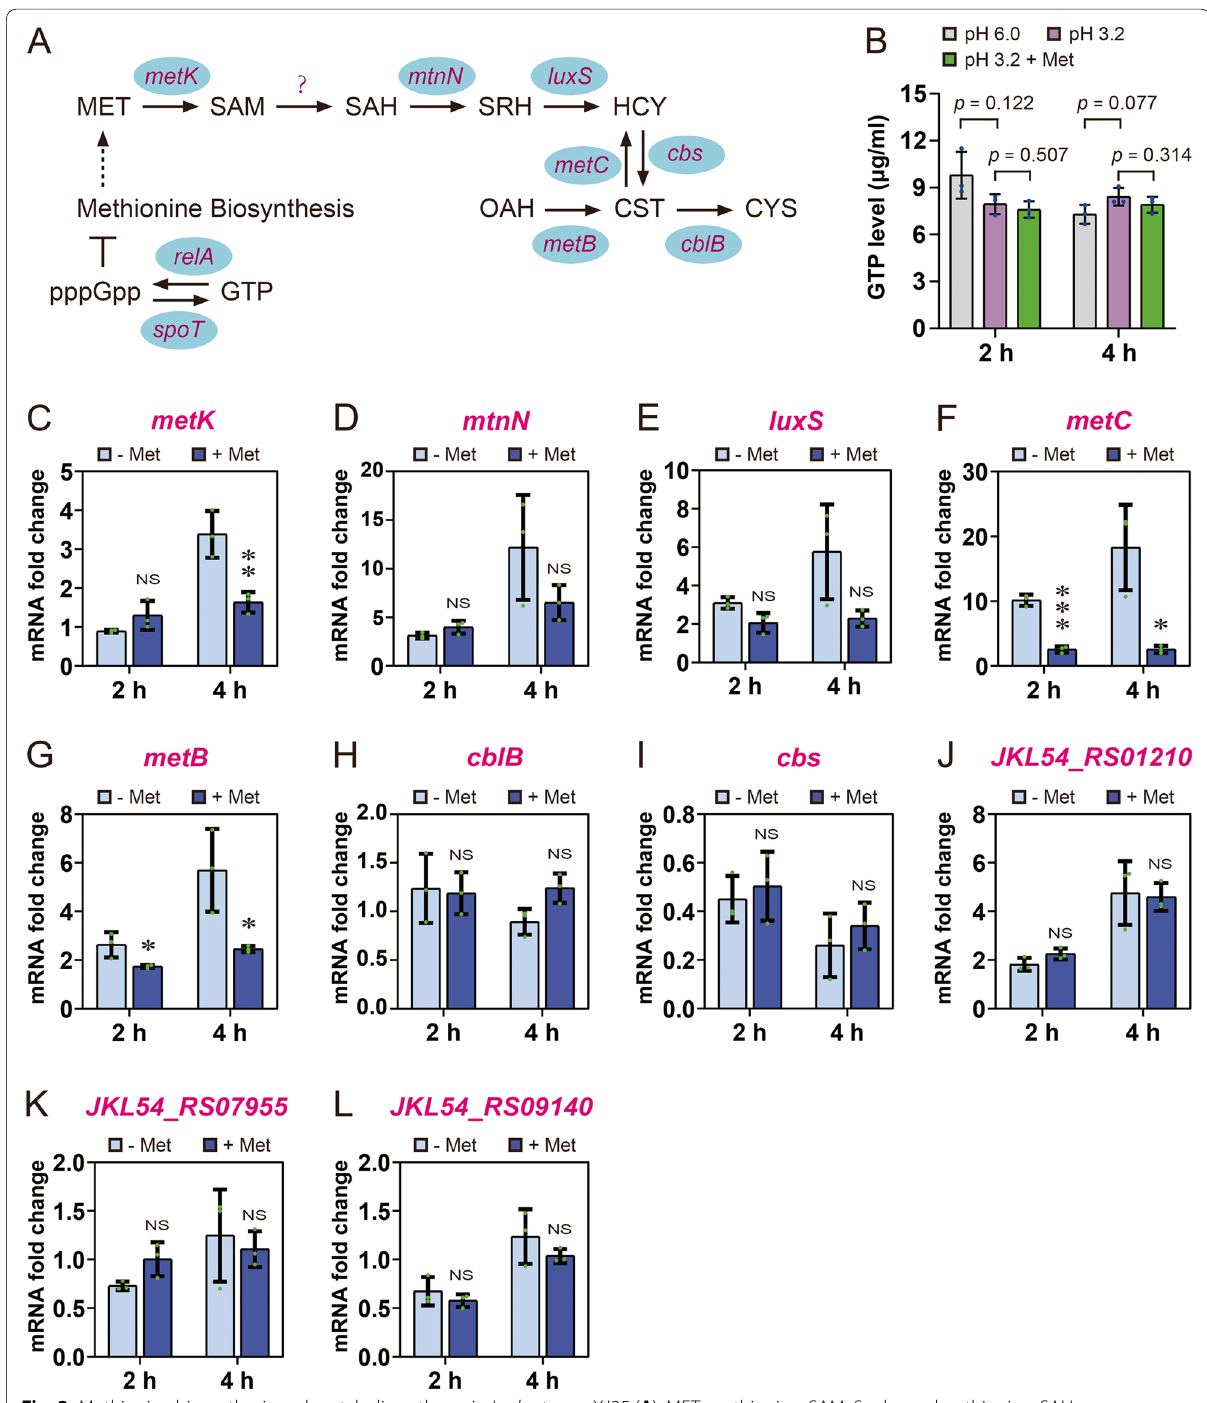
Fig. 3 Methionine biosynthesis and metabolic pathway in L. plantarum XJ25 ( A ). MET, methionine; SAM, S -adenosylmethionine; SAH, S -adenosylhomocysteine; SRH, S -ribosylhomocysteine; HCY, homocysteine; CST, cystathionine; CYS, cysteine; OAH, O -acetylhomoserine. The question mark indicated that the gene required for the biochemical reaction was not found in the genome of L. plantarum XJ25. Solid and dashed line arrow indicates a direct and indirect pathway, respectively. T-type arrow indicates an inhibitory effect. GTP levels of L. plantarum XJ25 under acid stress with and without the methionine supplementation ( B ). Met, 2 mM methionine. The numbers above the columns represent the statistical + significances between two group comparisons (Student’s t -test).The mRNA levels of metK ( C ), mtnN ( D ), luxS ( E ), metC ( F ), metB ( G ), cblB ( H ), cbs ( I ), JKL54_RS01210 ( J ), JKL54_RS07955 ( K ), JKL54_RS09140 ( L ) in the acid-stressed cells of L. plantarum XJ25 . Met, 2 mM methionine. * p < 0.05, ** + p < 0.01, *** p < 0.001, NS, not significant ( p > 0.05), comparison between the treatments with and without methionine